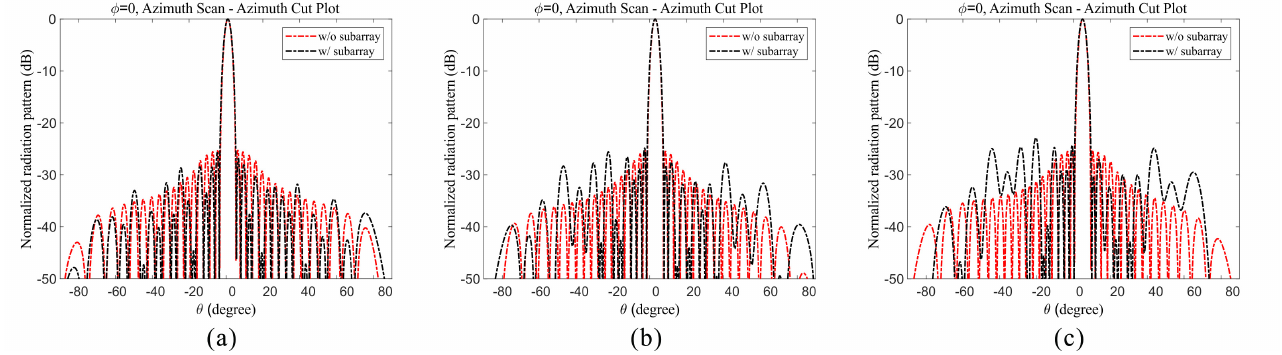
Figure 6. Radiation pattern when scanning the azimuth at 30 GHz (w/a subarray (96 TRMs) vs. w/o a subarray (576 TRMs)): ( a ) 1 ◦ scanning, ( b ) 3 ◦ scanning and ( c ) 5 ◦ scanning.